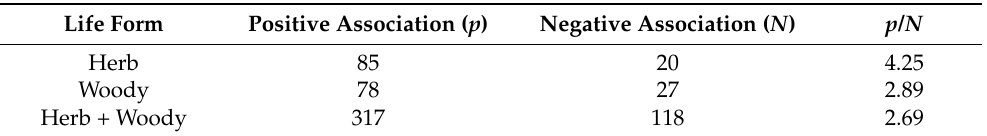
Figure 3. Results of χ 2 test of significantly association. The numbers represent the plants in Table 1. Table 4. V values of interspecific association among the 30 species at the Ziwuling study area on the Chinese Loess